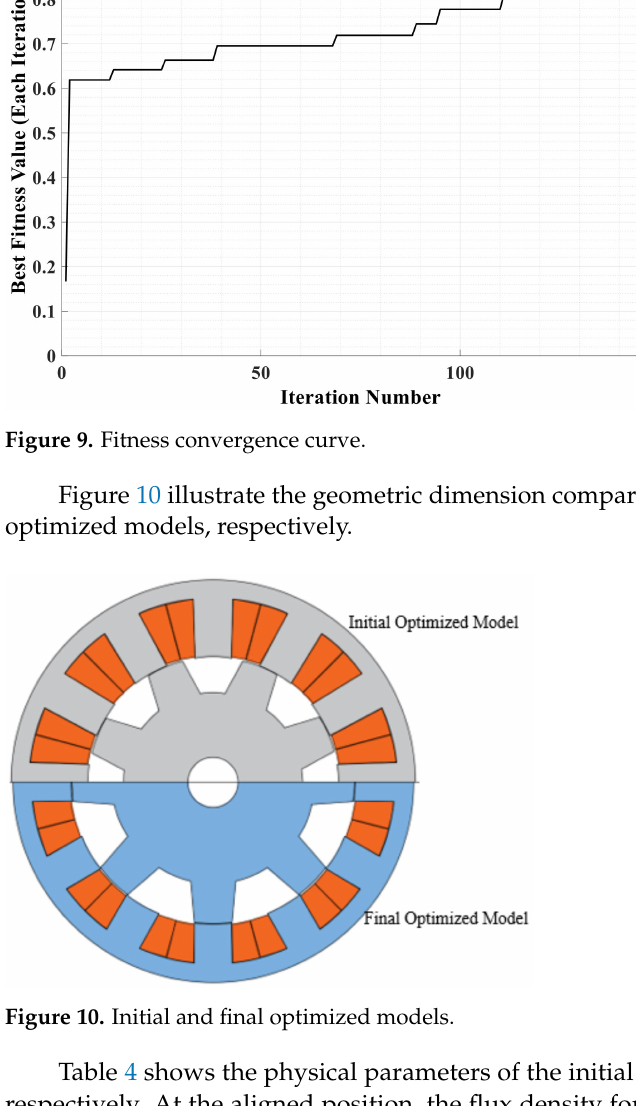
Figure 10. Initial and final optimized